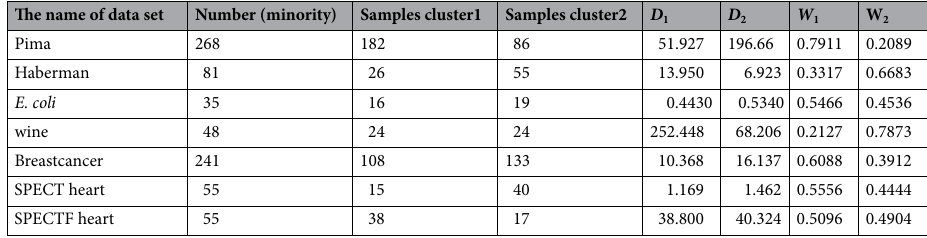
Table 3. The parameter information of SD-KMSMOTE.